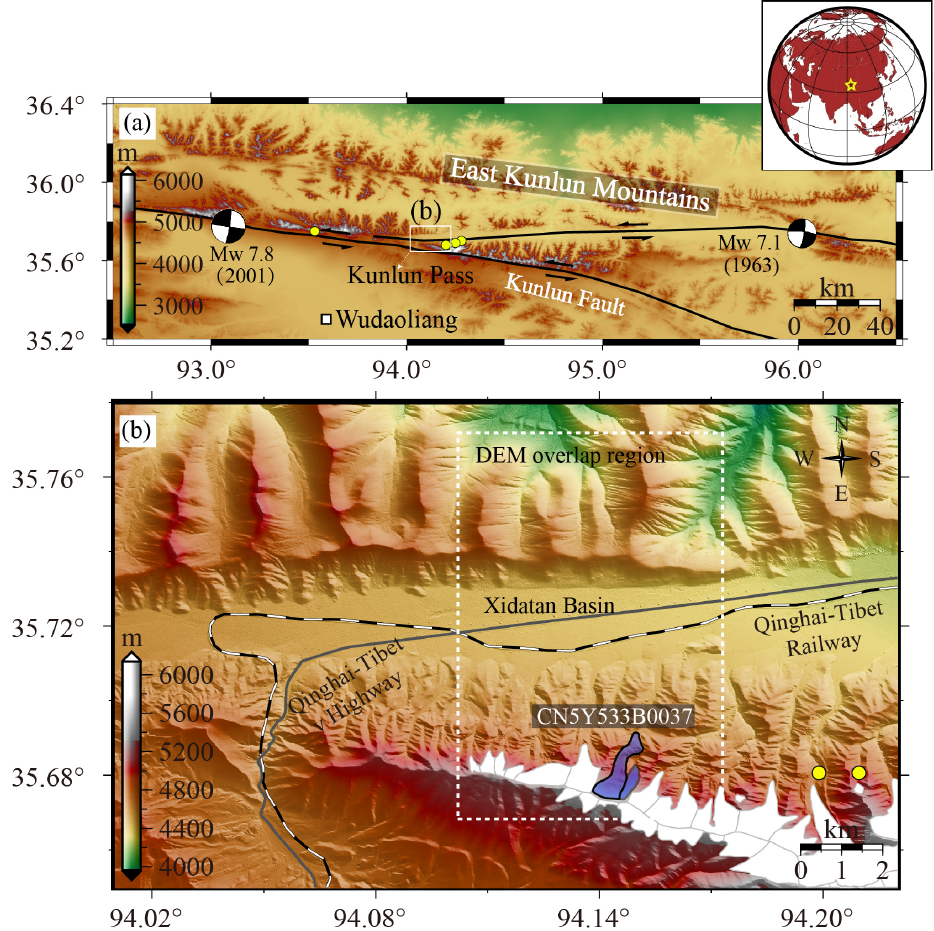
Figure 1. (a) The tectonic overview of the study area. The black lines depict the Kunlun fault traces. The yellow dots mark the ice avalanche locations induced by the 2001 M w 7.8 earthquake (Jerome et al., 2004). The white rectangle indicates the Wudaoliang meteorological station. (b) The topography of the Kunlun Pass region. The white rectangle shows the overlap region of the DEMs used in this study. The polygons are the glaciers from the GAMDAM glacier inventory (Sakai et al., 2019), and the one filled with purple color is the KLP-37 glacier, whose west branch is outlined in thick